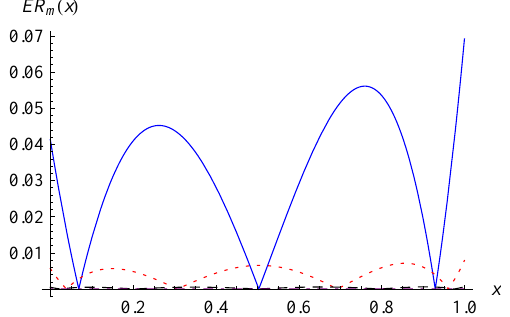
Figure 2. For λ = 2, the error functions ER m ( x ) for m = 2 (solid line), m = 3 (dot line), m = 4 (dash line) and m = 5 (dot-dash line).